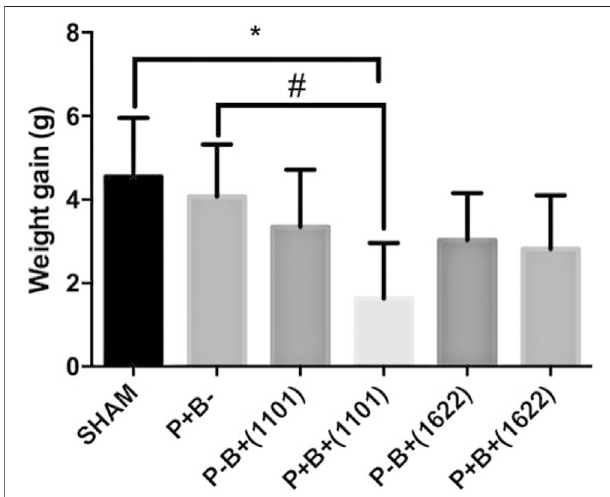
FIGURE 1 | Mean and SD of weight gain in grams after 45 days of experimentalperiodofC57Bl/6micesubmittedtodifferenttreatments:SHAM (negative control), P + B- (positive control), P-B+ (1101) ( B. breve 110 1A ), P + B+ (1101) (microbial consortium + B. breve 110 1A ), P-B+ (1622) ( B. bi fi dum 162 2A ) and P + B+ (1622) (Microbial consortium + B. bi fi dum 162 2A ). *Statistically signi fi cant difference in relation to negative control (SHAM), # Statisticallysigni fi cantdifferenceinrelationtopositivecontrol(P+B-).ANOVA, Tukey ’ s multiple comparison, p < 0.05%. Data representative of two independent experiments ( n (cid:1) 8 mice/per